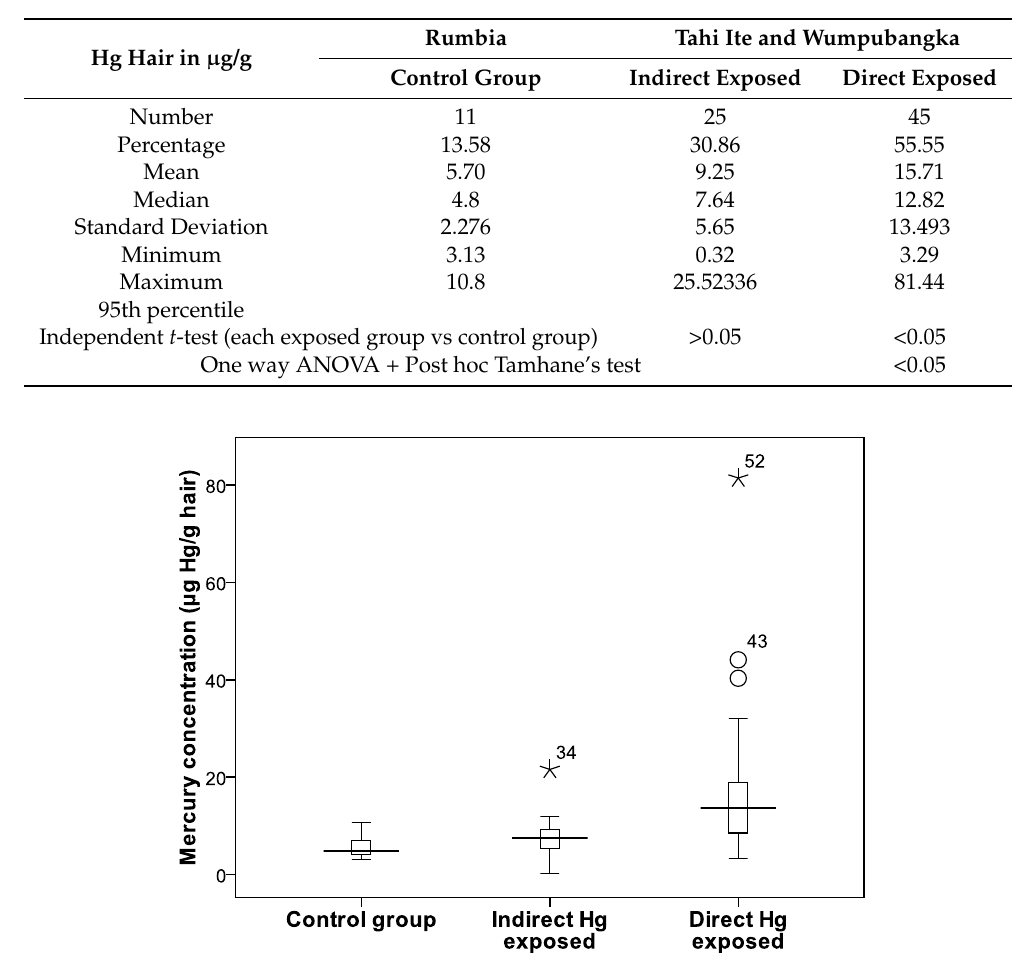
Table 3. Laboratory data based Human Biomonitoring (HBM) categories.